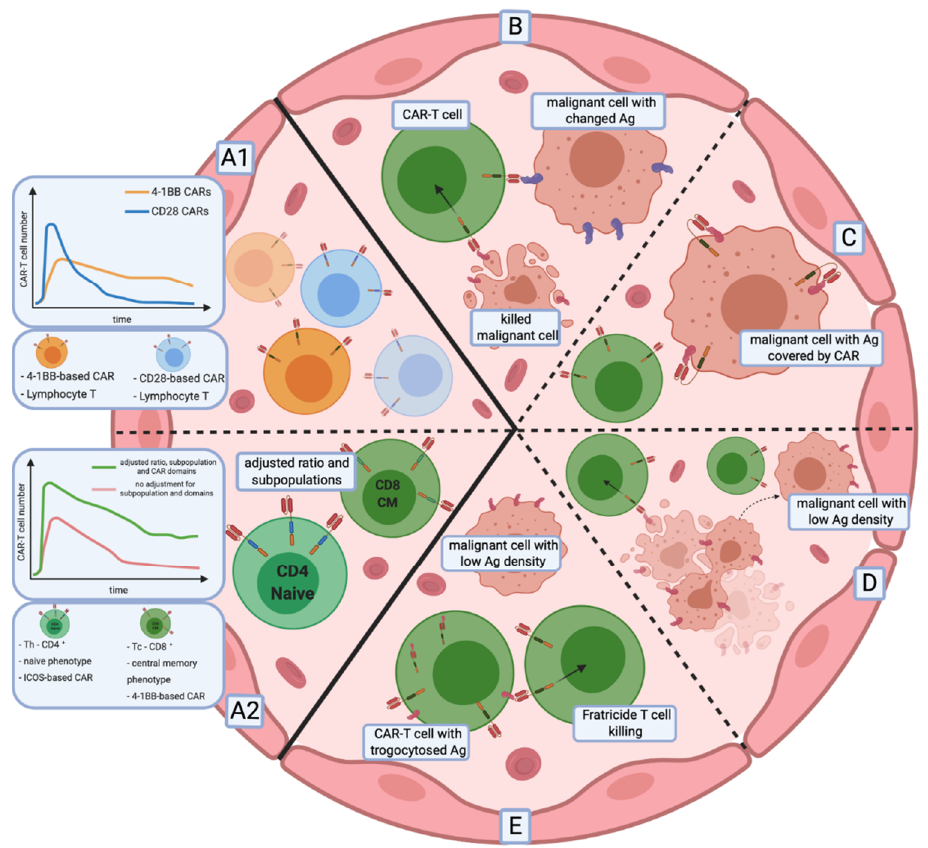
Figure 2. Remaining issues of CAR-T cell therapies in haemato-oncology. Relapses in a long-term observation after CAR-T cell infusion have two primary sources: CAR-T cells persistence ( A1 , A2 ) and the escape of malignant cells from immune surveillance ( B – E ). ( A1 ) The persistence and proliferation rate of CAR-T cells depends on the co-stimulation domains. Additionally, ( A2 ) subpopulation composition of the CAR-T cell infusion, as well as the phenotype of lymphocytes, influence the proliferation and persistence of modified effector cells. ( B – E ) Mechanisms of immune escape of neoplastic cells from CAR-T cells. ( B ) Targeted antigen changes as a result of mutation or splicing alteration. ( C ) Unintentional modification of neoplastic B cells with a CAR that masks the targeted epitope, rendering it undetectable by CAR-T cells. ( D ) Infusion of CAR-T cells triggers the selection of malignant cells with low antigen density that are resistant to effector cells. ( E ) The decrease of antigen surface level results from CAR-T cell-mediated trogocytosis, with subsequent induction of fratricide T cell killing and CAR-T cells with an exhausted phenotype. Abbreviations: Th—helper T cell, Tc—cytotoxic T cell, ICOS-based CAR—inducible co-stimulator-based CAR.